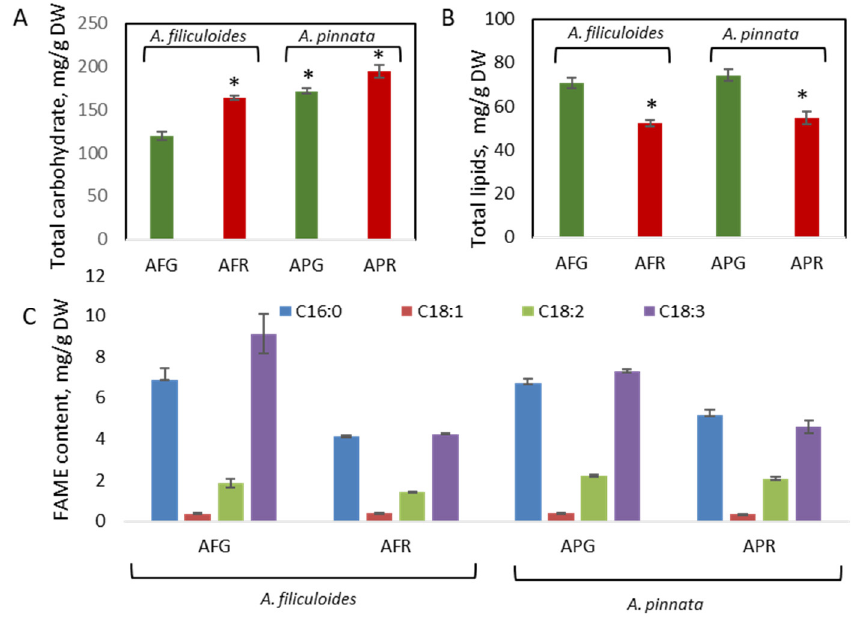
Figure 4. Accumulation of carbohydrates ( A ) and total lipids ( B ) in green and red A. filiculoides and A. pinnata. Fatty acid methyl ester (FAME) composition of lipids ( C ). AFG: A. filiculoides _Green; AFR: A. filiculoides _Red; APG: A. pinnata _Green; APR: A . pinnata _Red. (ANOVA; * p < 0.05 compared to AFG).